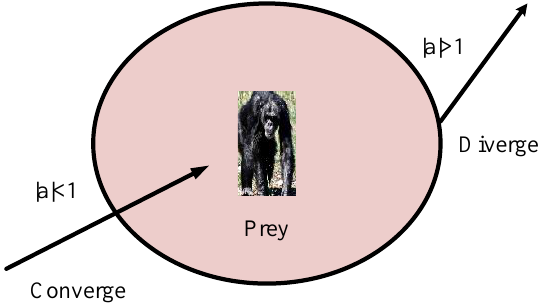
Figure 3. Effect of ‘a’ on updating the mechanism of chimps’ location. Chaotic Maps (Sexual